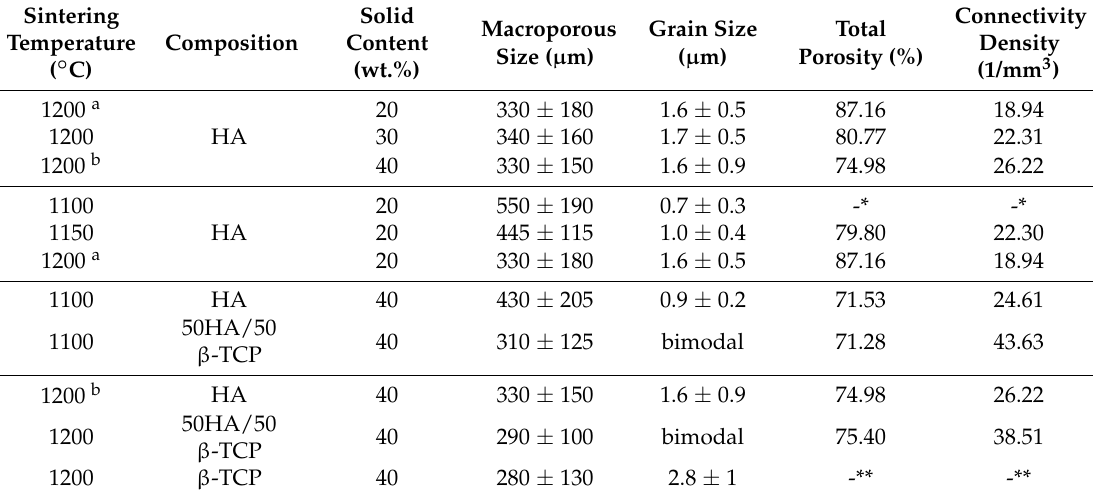
Table 1. Dependence of grain size, pores size, total porosity or density of interconnection of scaffolds obtained from CaP nanoparticles with different slurry solid content, sintering temperature or